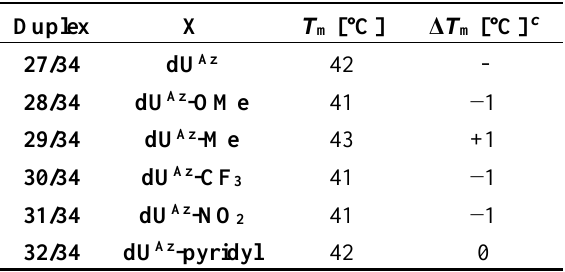
Table 6. T m values of duplexes formed by dU Az analogue-modified ONs with complementary RNA a . Duplex X T m [°C] Δ T m [°C] c 27/34 dU Az 42 - 28/34 dU Az -OMe 41 −1 29/34 dU Az -Me 43 +1 30/34 dU Az -CF 3 41 −1 31/34 dU Az -NO 2 41 −1 32/34 dU Az -pyridyl 42 0 least three data points. The T m value of natural DNA 26 /RNA 34 duplex is 47 °C; b The Δ T m indicates the difference from ON 27 /RNA 34 duplex.